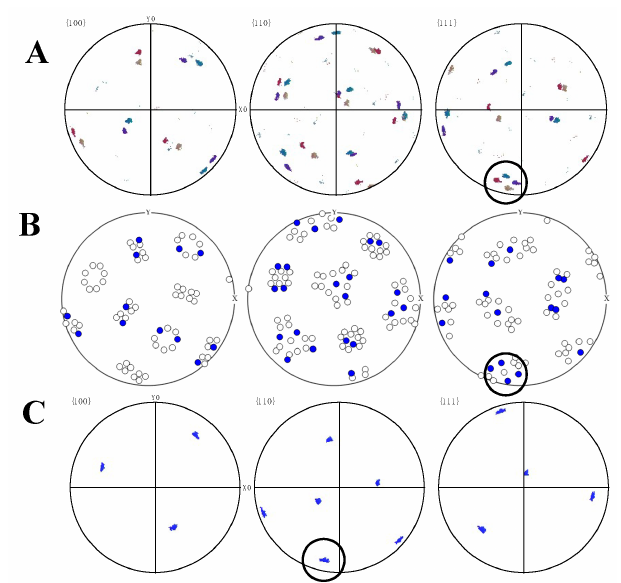
Figure 8. Variant selection in the single parent grain presented in Figure 5A. The circle indicates that the < 111 > α scatters about the < 110 > γ that is closest to the traction axis which is oriented along the y-direction. ( A ) Experimental pole figures of the martensite. ( B ) Kurdjumov–Sachs pole figures with the variant selected by our criterion marked in blue. ( C ) Experimental pole figures of the parent